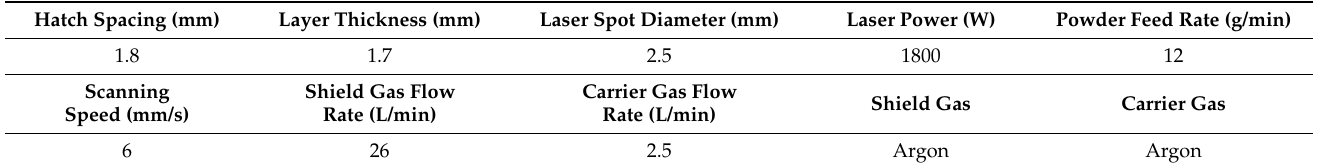
Table 1. DED manufacturing parameters.